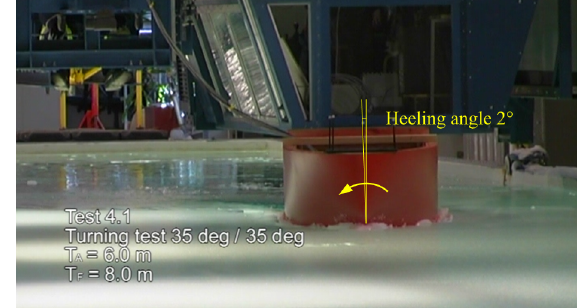
Figure 20: Estimated average heeling angle during the turning test.